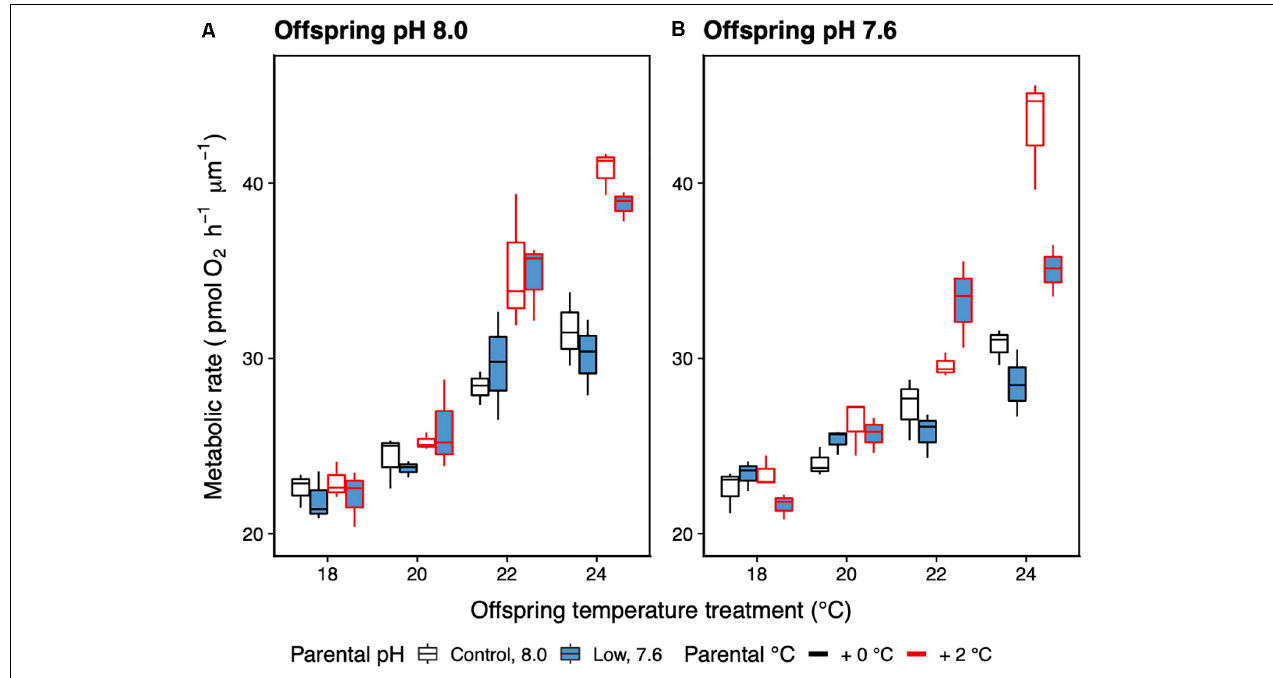
FIGURE 6 | Mean metabolic rate ( ± SE) of 14-day-old juvenile offspring of H. erythrogramma parents that were acclimated for 3 months at two temperature (black outline: ambient, red outline: +2 ◦ C) and two pH T (white: 8.0, blue: 7.6) levels (A,B) . The juveniles were reared in a range of temperatures (18–24 ◦ C). n = 3.